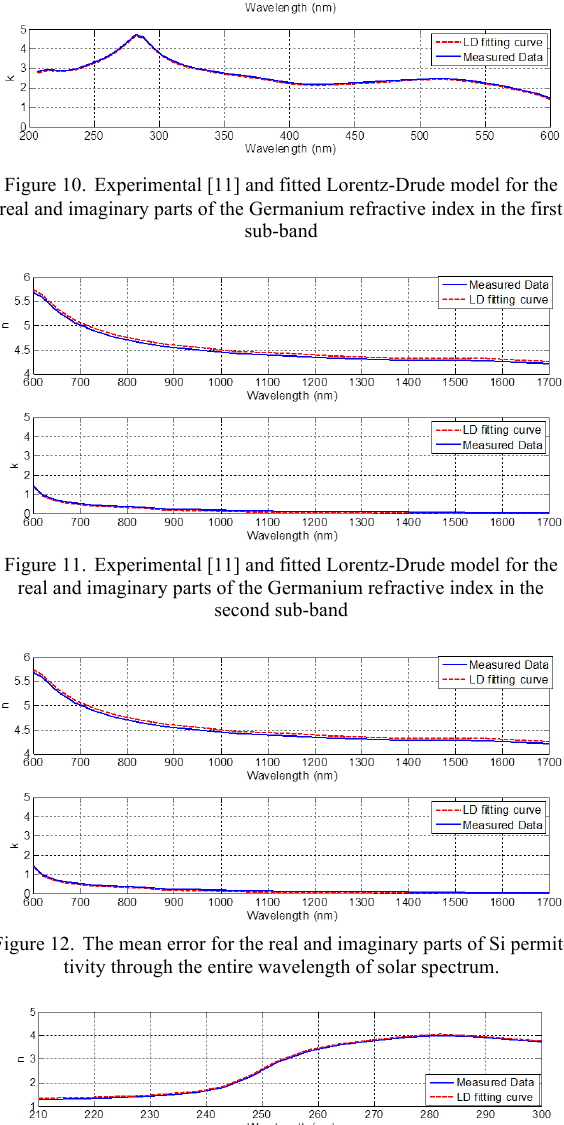
Figure 7. Experimental [9] and fitted Lorentz-Drude model for the real and imaginary parts of the silicon permittivity in the second sub-band where the imaginary part is plotted in both linear and log scales.